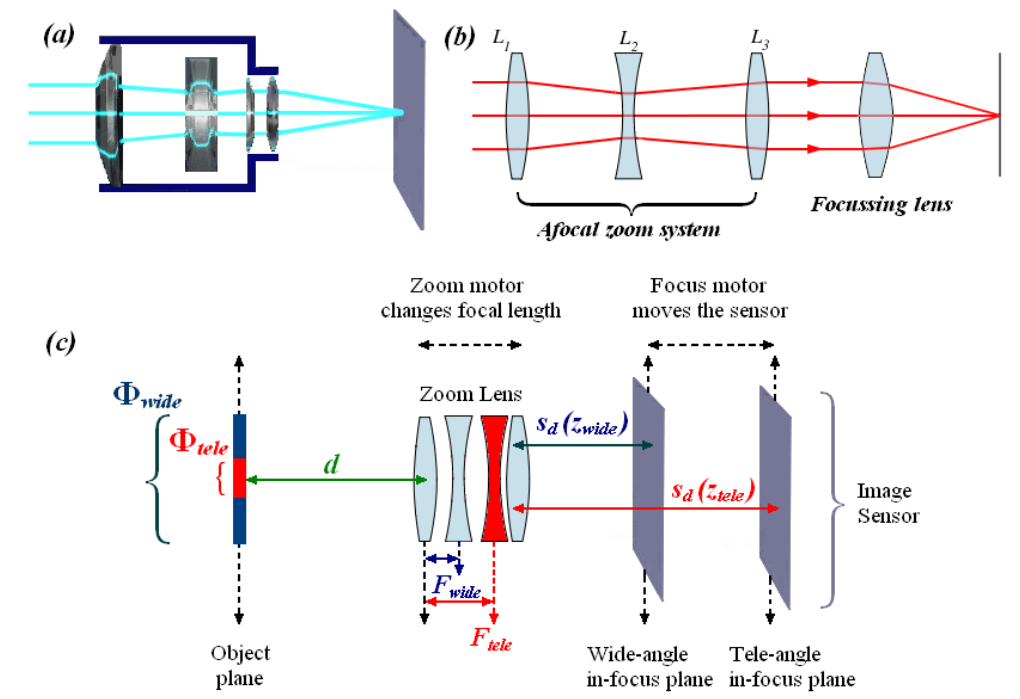
Figure 2. ( a ) Illustration of an actual zoom system; ( b ) The structure of a zoom system; ( c ) Zoom tracking mechanism.